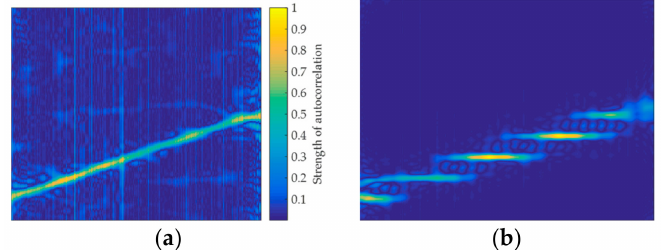
Figure 10. Noise reduction ability analysis of short-time auto-correlation image when SNR is 0 dB: